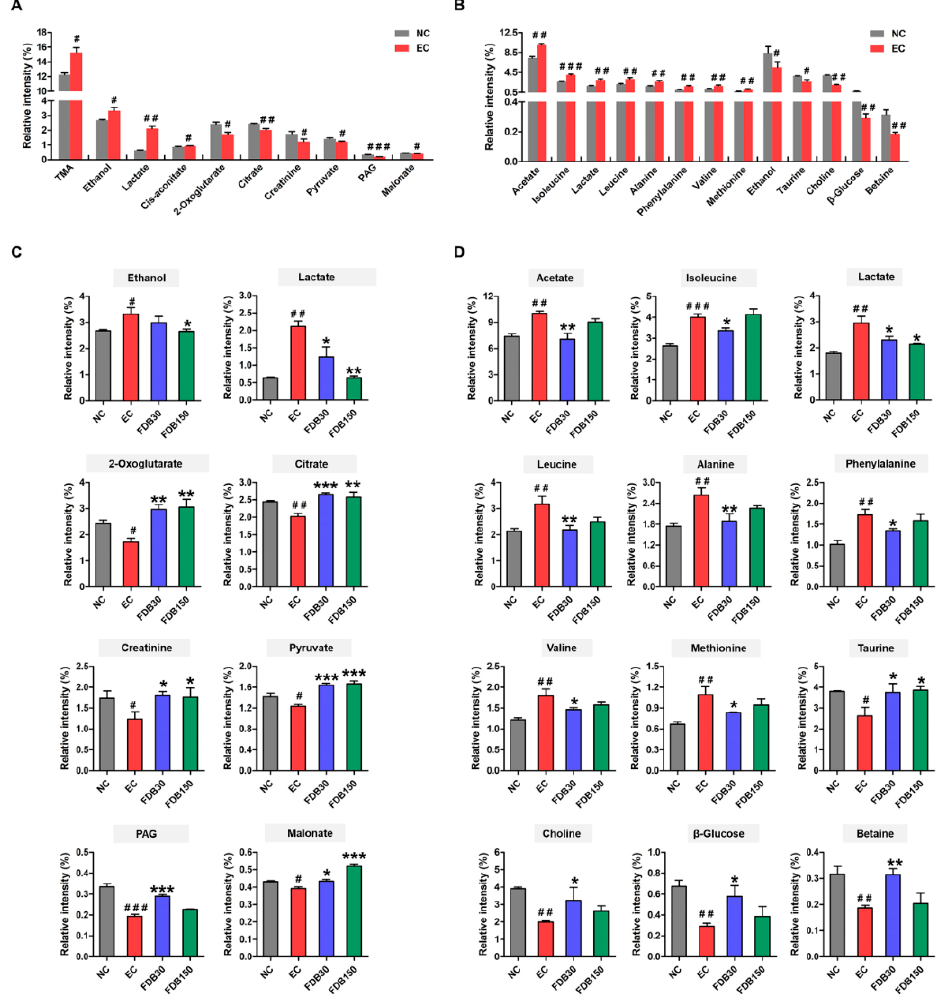
Figure 4. Effects of FDB on urinary and small intestine metabolites in fatigued mice. Significant changes in ( A ) urinary and ( B ) small intestine metabolites in NC and EC groups are shown in the histogram. Significant changes in ( C ) urinary and ( D ) small intestine metabolites in EC and FDB-treated groups are shown in the histogram. # p < 0.05, # # p < 0.01, and # # # p < 0.001 vs. normal control (NC) group; * p < 0.05, ** p < 0.01, and *** p < 0.001 vs. exercise control (EC) group. FDB30: 30 mg/kg FDB group; FDB150: 150 mg/kg FDB group. TMA: trimethylamine; PAG: phenylacetyl gly- cine.